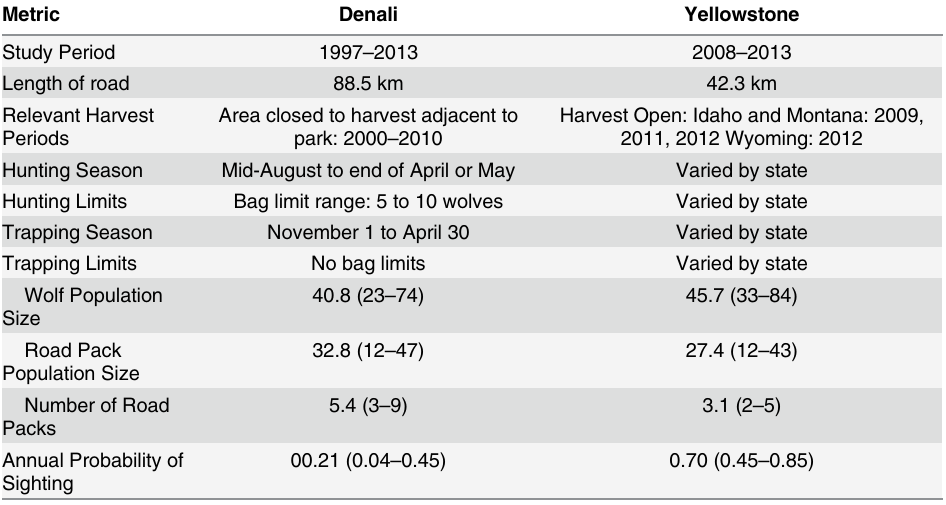
Table 1. Metrics summarizing wolf sighting datasets in Denali (Denali National Park and Preserve, Alaska, USA) and Yellowstone (Yellowstone National Park, Wyoming, USA). Table entries for wolf